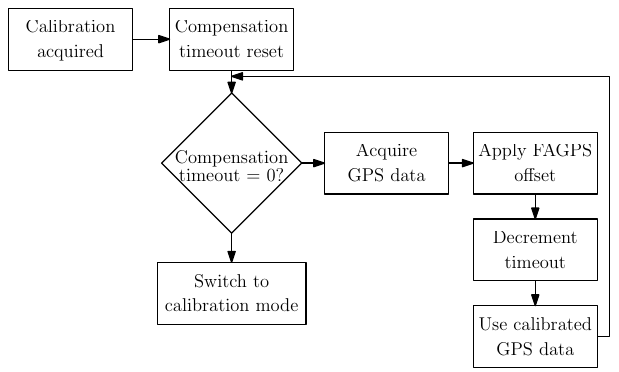
Figure 3. FAGPS Compensation Flow